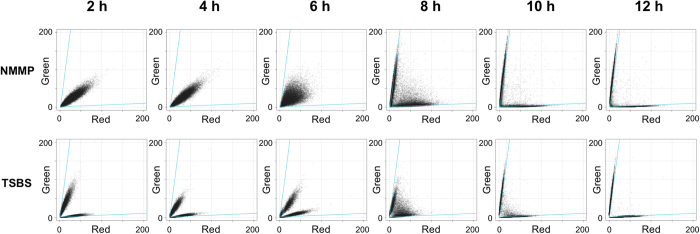
Quantitative analysis of time-dependent aggregation.Fluorescence profiles of 24-hour-old pellets obtained from co-cultures of S. lividans pRed and S. lividans pGreen that had initially been grown separately for 2, 4, 6, 8, 10, or 12 h. Each plot represents the fluorescence intensities of pellets in the red (X-axis) and green (Y-axis) channel determined by particle analysis. The growth media were NMMP (top) and TSBS (bottom). Note that aggregation is strongly reduced when the fluorescent strains have initially been grown separately for more than 8 h.